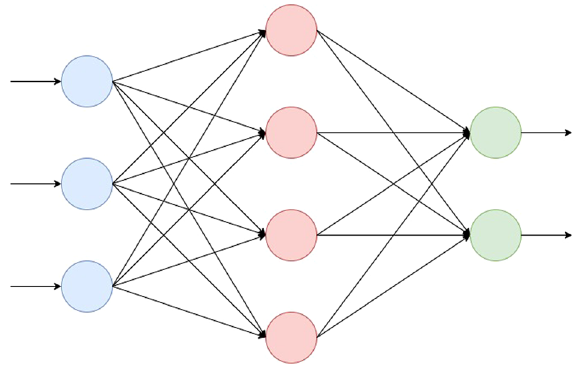
Figure 23. A multilayer perceptron with three layers of